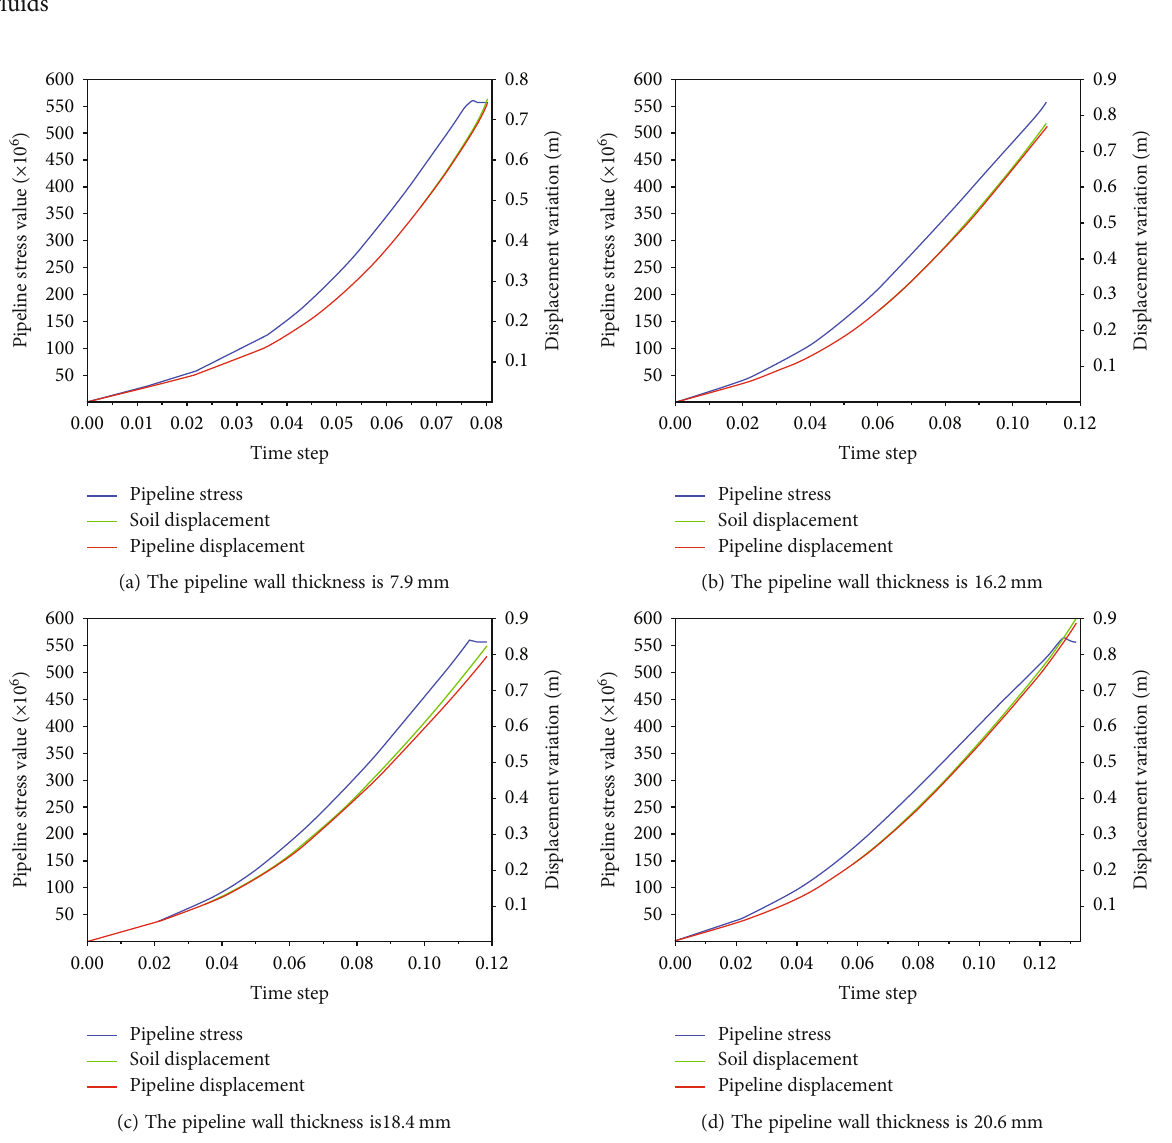
Figure 15. The maximum displacement of the pipeline under yield increases with the increase of wall thickness. As the outer diameter of the pipeline is the same, the increase of wall thick- ness causes the increase of pipeline gravity and stronger bearing capacity. Under the same conditions, when the pipeline reaches yield, the maximum displacement of the pipeline will also increase. Under di ff erent working conditions, the distribution area of displacement variation is similar, which is a large distri- bution in the middle and small at the two ends.